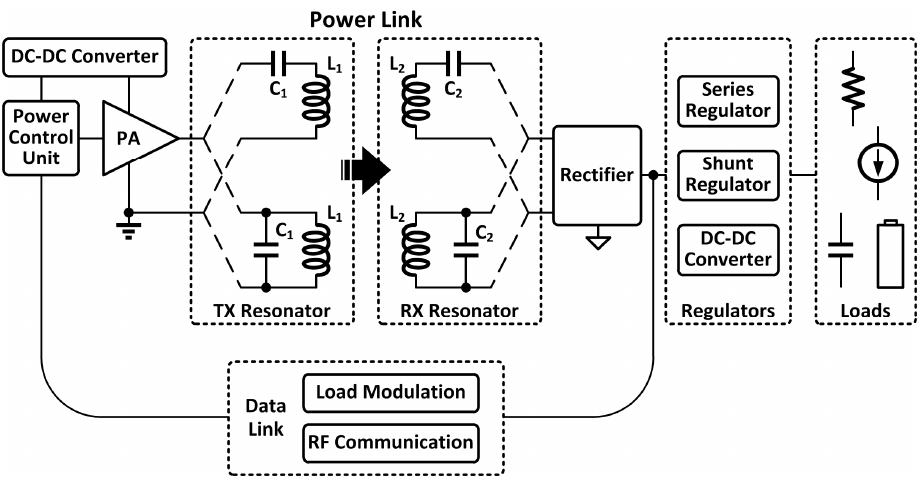
Figure 1. The block diagram of a non-specific inductive WPT system.